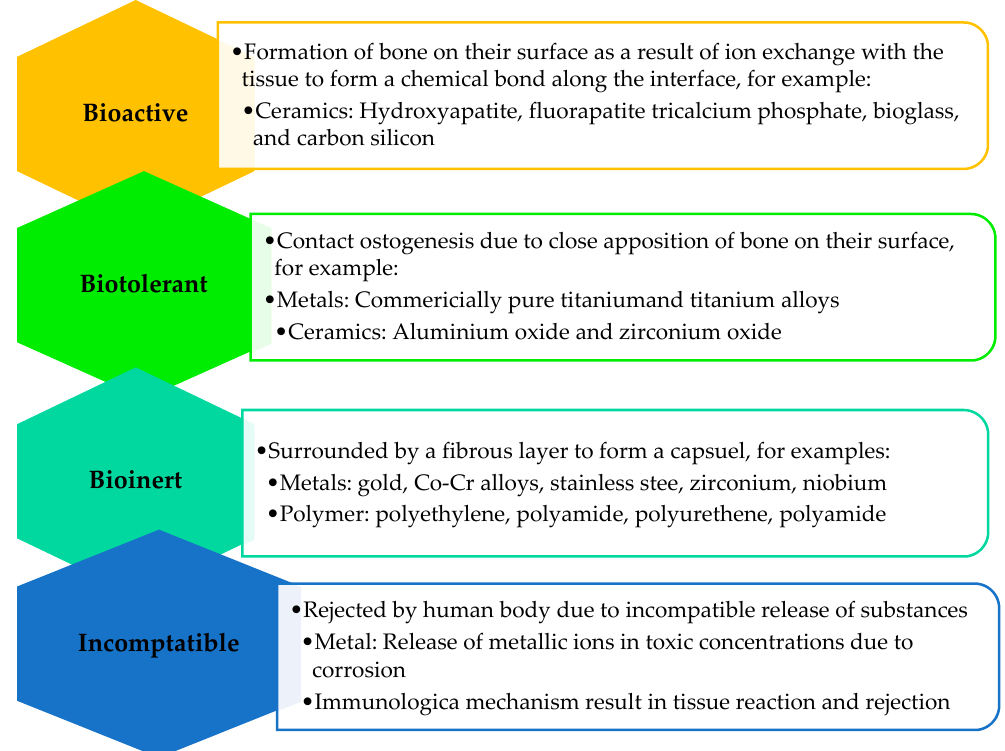
Figure 4. Possible biological responses to different materials when placed in human body.